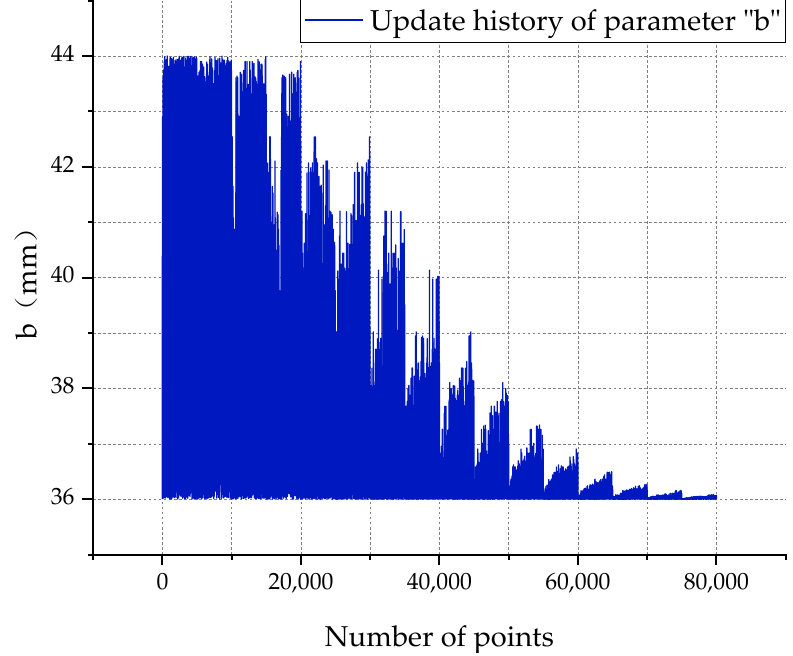
Figure 21. The iterative process of parameter “b”.